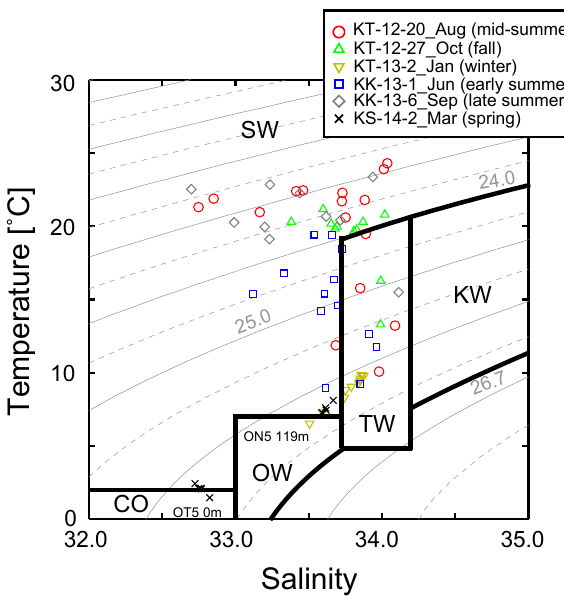
Figure 3. Temperature–salinity diagram at each sampling point. The water classification was defined by Hanawa and Mitsud- era (1986). SW, KW, TW, OW, and CO denote the surface layer water system, Kuroshio water system, Tsugaru Warm Current water system, Oyashio water system, and Coastal Oyashio water system, respectively.